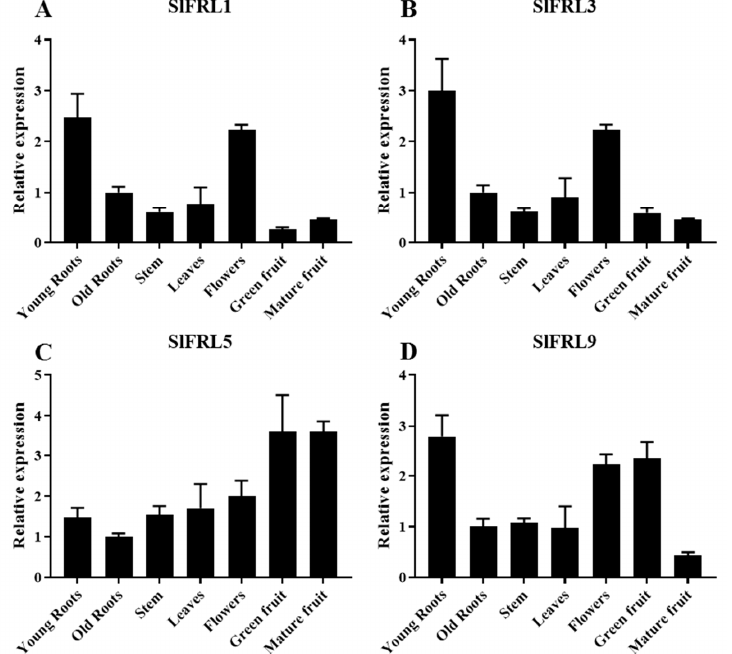
Figure 4. The relative expression of genes SIFRL1 ( A ), SIFRL3 ( B ), SIFRL5 ( C ), SIFRL9 ( D ) in different parts in the MT-d + . Three samples were expressed as mean ± standard deviation (error line). SlUBI3 was used as the internal reference gene.